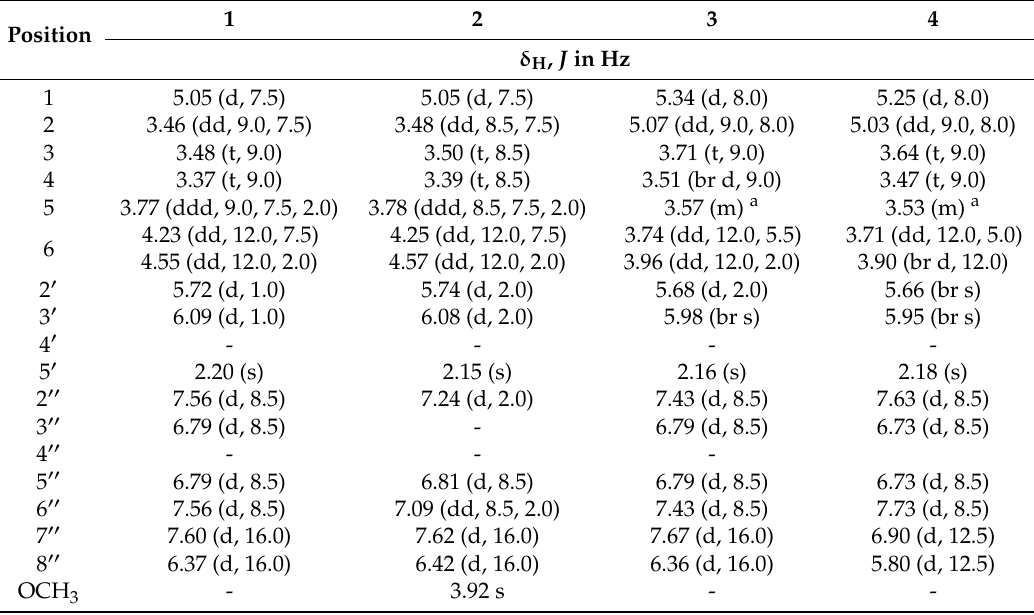
Table 1. 1 H-NMR (500 MHz) spectroscopic data for 1 – 4 in CD 3